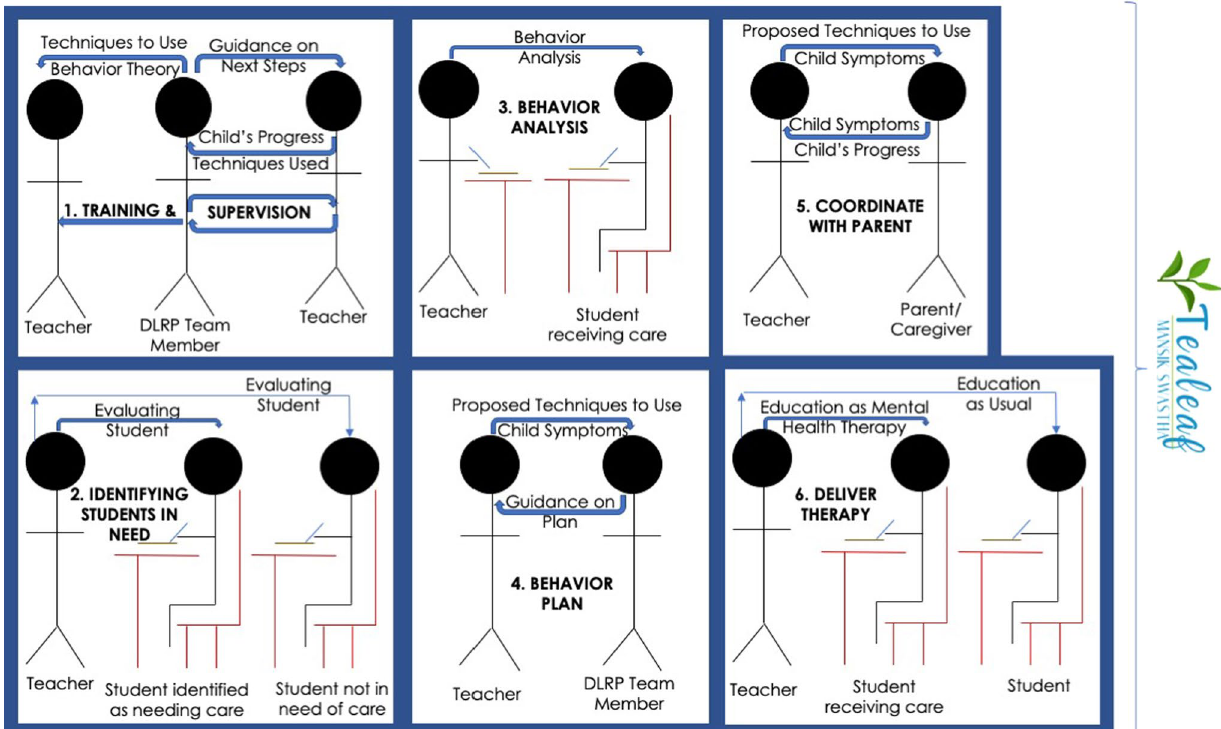
Fig. 1 Tealeaf’s 6 components are illustrated here. First, teachers receive training and supervision from study staff. Second, teachers under supervision identify children in need of mental health support in their classrooms. Third, teachers perform a behavior analysis on students to begin to understand targeted behaviors. Fourth, teachers create a behavior plan, choosing therapeutic techniques to use that target behaviors identified in behavior analysis and ones they feel they can implement during the school day. Fifth, teachers coordinate with par- ents, informing them of their child’s progress at school, learning of their child’s progress at home, and guiding how Tealeaf techniques may be used at home. Finally, teachers deliver therapy during the school